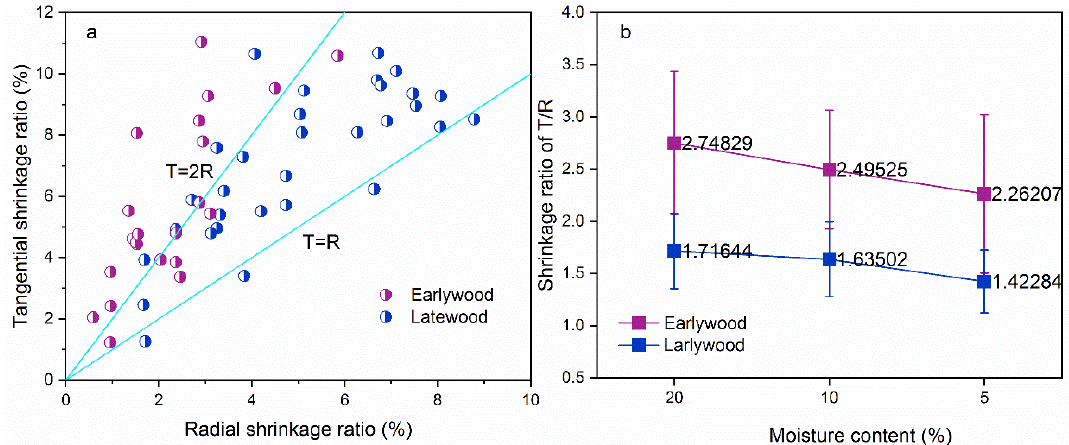
Figure 8. Anisotropic shrinkage between the T and R directions at the cellular level: ( a ) T shrinkage ratio vs. R ratio of early- and latewood tracheids and ( b ) T/R ratio of early- and latewood tracheids at different MCs.